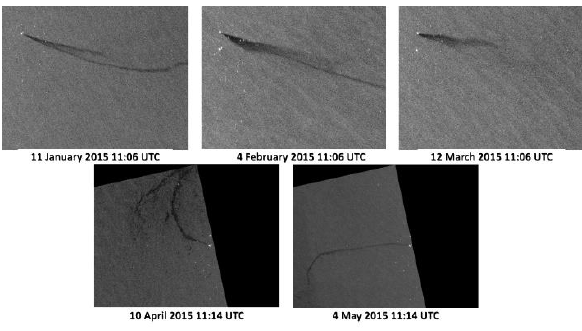
Figure 3. Case study of frequent oil pollution caused by offshore oil industry. The bright spot, from which the dark patches in all panels origin, is an oil rig off Java, at 5°54’42”S 107°55’35”E.